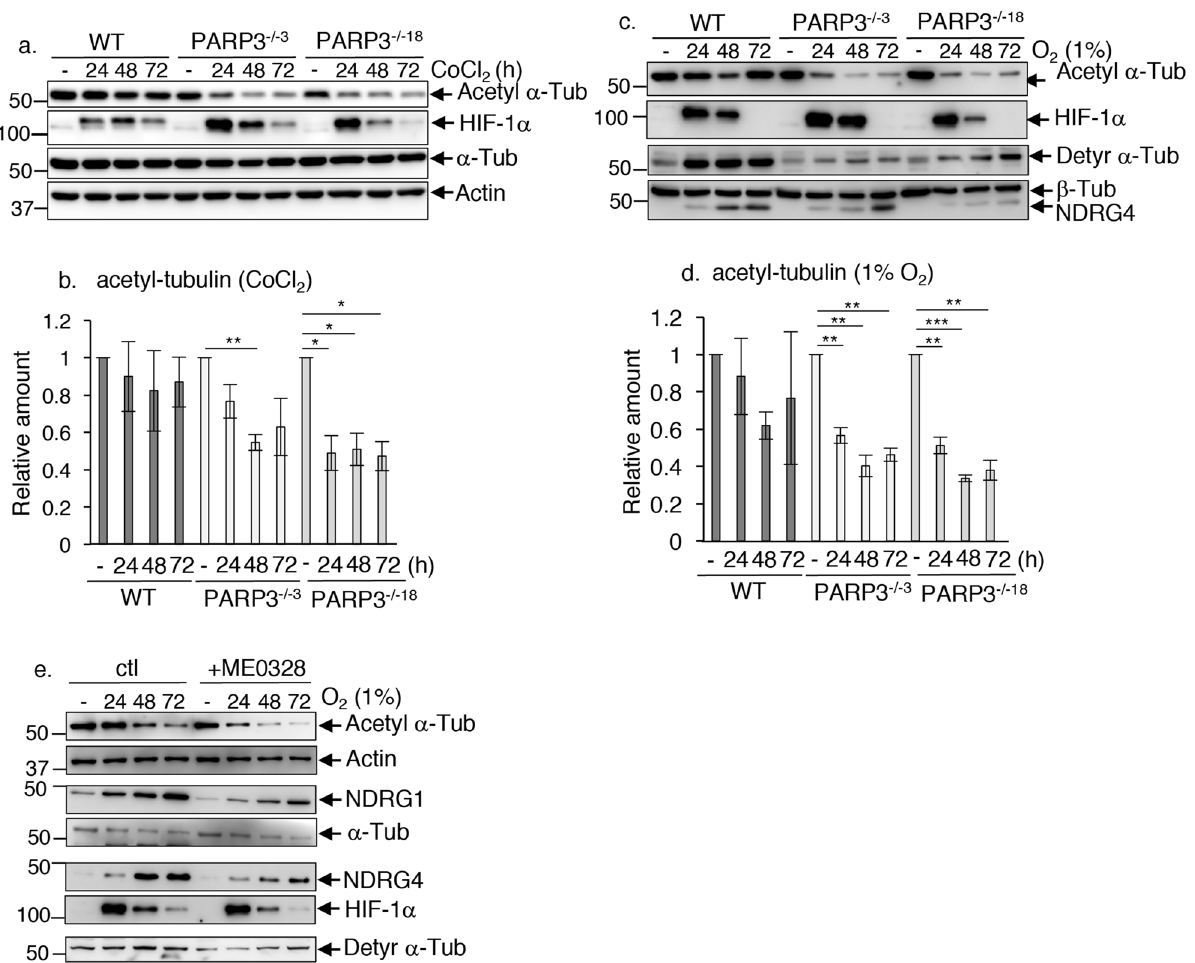
Figure 7. PARP3 deficiency destabilizes cytoskeleton microtubules under hypoxia. ( a , b ) PARP3 deficiency reduces tubulin acetylation during CoCl 2 -induced hypoxia. ( a ) The parental WT, PARP3 −/−3 and PARP3 −/−18 LN229 cells were maintained under CoCl 2 -induced hypoxia for the indicated time points. Acetyl α-Tubulin, HIF-1α α-tubulin and actin were analysed by western blotting using the appropriate antibodies. Uncropped Western-blots are shown in the supplementary information file. ( b ) Bar graphs depict the relative signal intensities of acetyl α-Tubulin versus α-Tubulin measured in three independent experiments using Image J. Mean values ± s.d are indicated. *p < 0.05, **p < 0.01. ( c , d ) PARP3 deficiency reduces tubulin acetylation under 1% O 2 -induced hypoxia. ( c ) The parental WT, PARP3 −/−3 and PARP3 −/−18 LN229 cells were cultured under 1% O 2 -induced hypoxia for the indicated time points. Acetyl α-Tubulin, detyr α-Tubulin, β-Tubulin, HIF-1α were analysed by western blotting using the appropriate antibodies. Uncropped Western-blots are shown in the supplementary information file. ( d ) Bar graphs depict the relative signal intensities of acetyl α-Tubulin versus β-Tubulin measured in three independent experiments using Image J. Mean values ± s.d are indicated. **p < 0.01, ***p < 0.001. ( e ) The chemical inhibition of PARP3 (ME0328) reduces tubulin acetylation, tubulin detyrosination, and impairs NDRG1 and NDRG4 upregulation under O 2 -induced hypoxia. Mock-treated and ME0328-treated LN229 cells were cultured under 1%O 2 -induced hypoxia for the indicated time points. Acetyl α-Tubulin, α-Tubulin, detyr α-Tubulin, HIF-1α, NDRG1, NDRG4 and actin were analysed by western blotting using the appropriate antibodies. Uncropped Western-blots are shown in the supplementary information